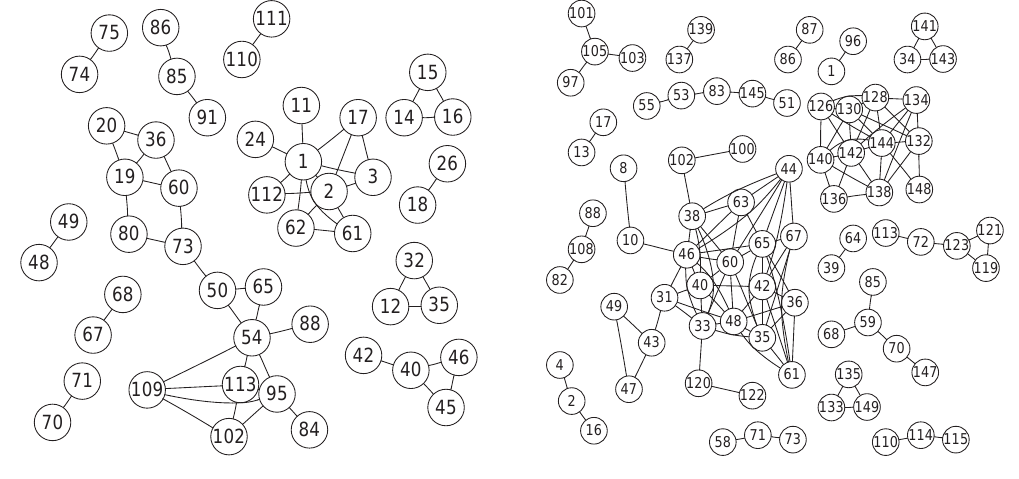
Figure 1: Correlation networks, using a threshold of θ = 0 . 7 , showing the complex correlation structure within the original experimental data metabolites (left) and samples